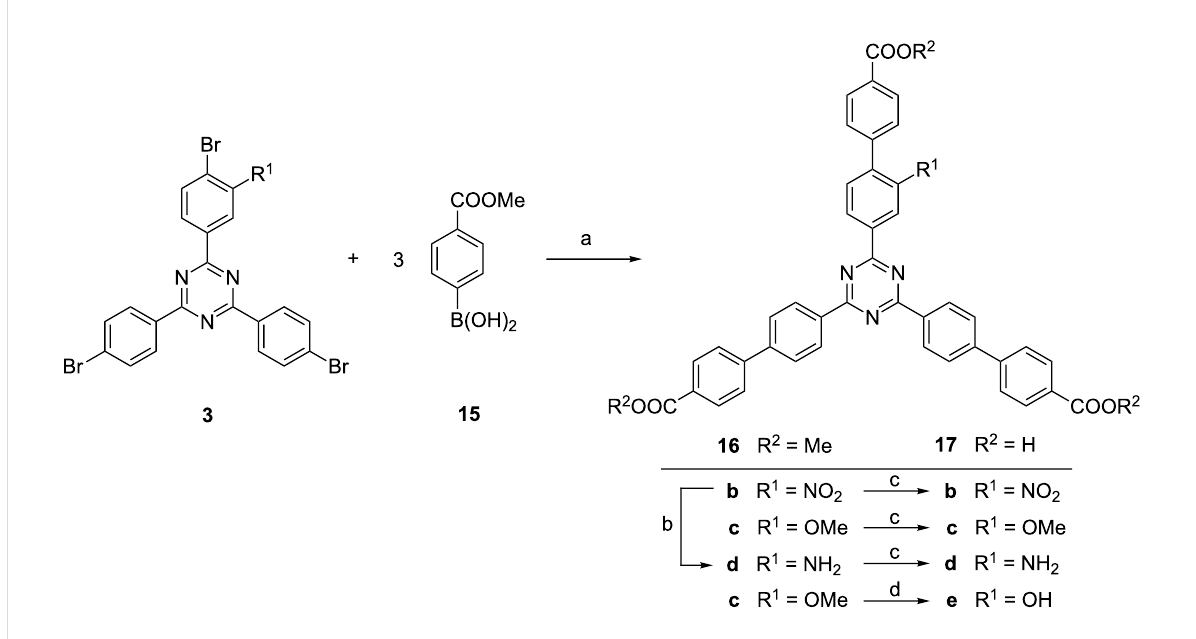
Figure 7: Triple Suzuki–Miyaura coupling between tribromotriazines 3 and boronic acid 15 and subsequent hydrolyses of the esters 16 . Conditions: a) Pd(PPh